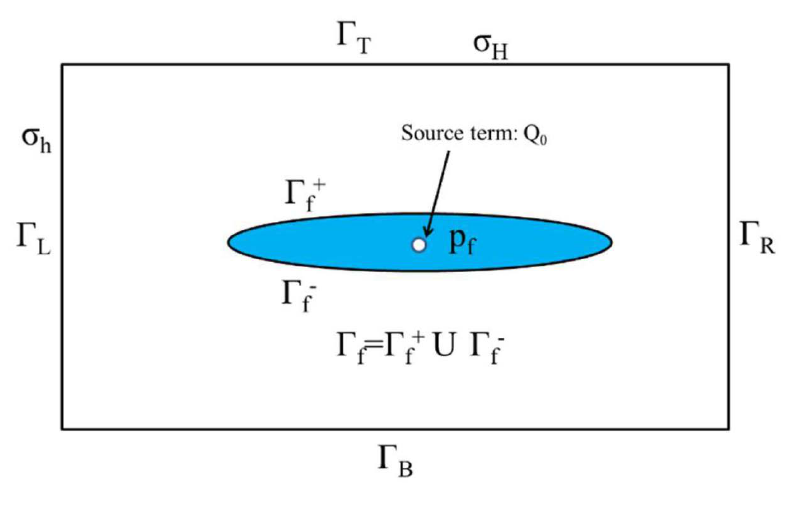
Figure 1. Schematic of